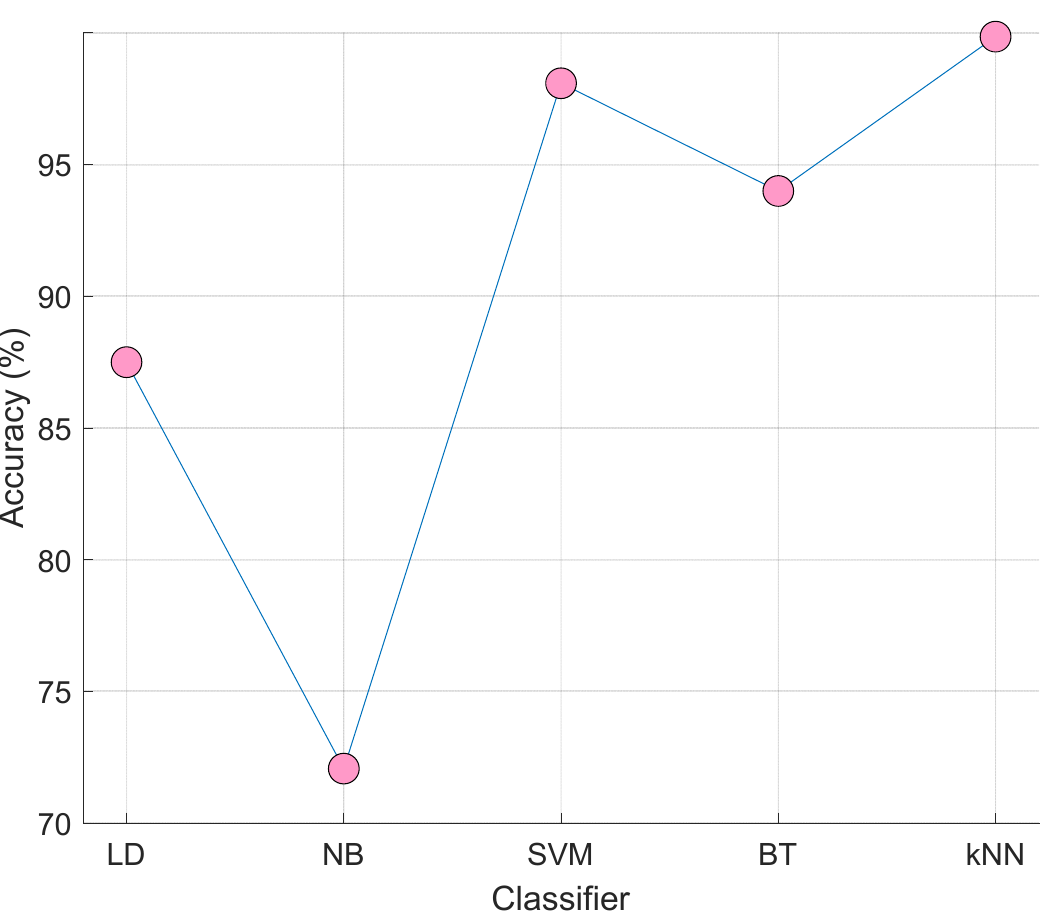
Figure 5. Results of the LD, NB, SVM, BT, and kNN classifiers on the selected 413 features.